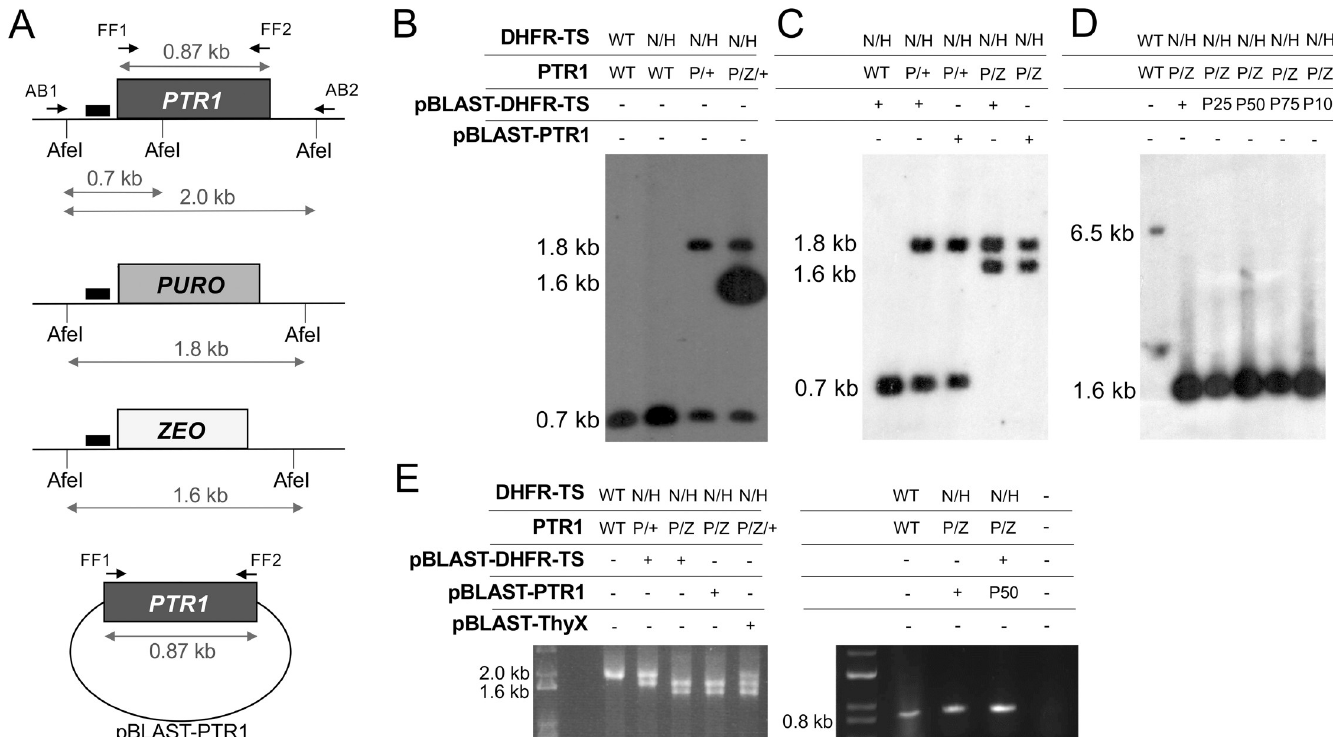
Fig 5. Disruption of PTR1 in chromosomal DHFR-TS null mutants. (A) Schematic representation of the PTR1 locus and of the integration of the puromycin N-acetyl transferase (PURO) and zeocin resistance gene (ZEO) deletion cassettes. The expected sizes after digestion with AfeI when hybridized to probe 2 (small black boxes) are shown. Also shown are the expected size of PCR fragments generated with primers FF75 and FF76 amplifying the coding sequence of PTR1 , or with primers AB1 and AB2 located in its 5’ and 3’UTRs, respectively. The pSP72 α Blast α -PTR1 episome is shown at the bottom. All cells from this Fig were grown in the presence of 50 μ g/ml thymidine. (B and C) Southern blot analysis of genomic DNAs digested with AfeI hybridized with probe 2. The genotype of the strains for each lane is indicated on top of the blots. In panel B, the hybridized band with the ZEO integration is more intense than expected. This is likely due to tandem integration of the marker during selection. WT and +, wildtype; N, NEO; H, HYG; P, PURO; Z, ZEO; pBLAST, pSP72 α Blast α . (D) Southern blot analysis of total DNAs (genomic and episomal) digested with XbaI and HindIII and hybridized to an intragenic DHFR-TS probe (see also S2 Fig). The genotype of the strains for each lane is indicated on top of the blot. WT and +, wildtype; N, NEO; H, HYG; P, PURO; Z, ZEO; pBLAST, pSP72 α Blast α . P25, P50, P75 and P100 mean that parasites harboring the pSP72 α Blast α -DHFR-TS episome were grown for 25, 50, 75 and 100 passages in absence of blasticidin in the presence of excess thymidine. (E) Left panel . Amplification of the PTR1 locus with primers AB1 and AB2 shows the replacement of PTR1 alleles by PURO and ZEO markers in the chromosome of DHFR-TS NEO/HYG PTR1 PURO/ZEO cells harboring episomes coding for DHFR-TS or PTR1. Right panel . Amplification of the PTR1 coding sequence with primers FF75 and FF76 confirms that the psp72 α blast α - PTR1 episome is not lost from DHFR-TS NEO/HYG PTR1 PURO/ZEO cells in the absence of blasticidine. The genotype of the strains for each lane is indicated on top of the gels. WT and +, wildtype; N, NEO; H, HYG; P, PURO; Z, ZEO; pBLAST. P50, parasites harboring the pSP72 α Blast α -PTR1 episome grown for 50 passages in the absence of blasticidin in the presence of excess